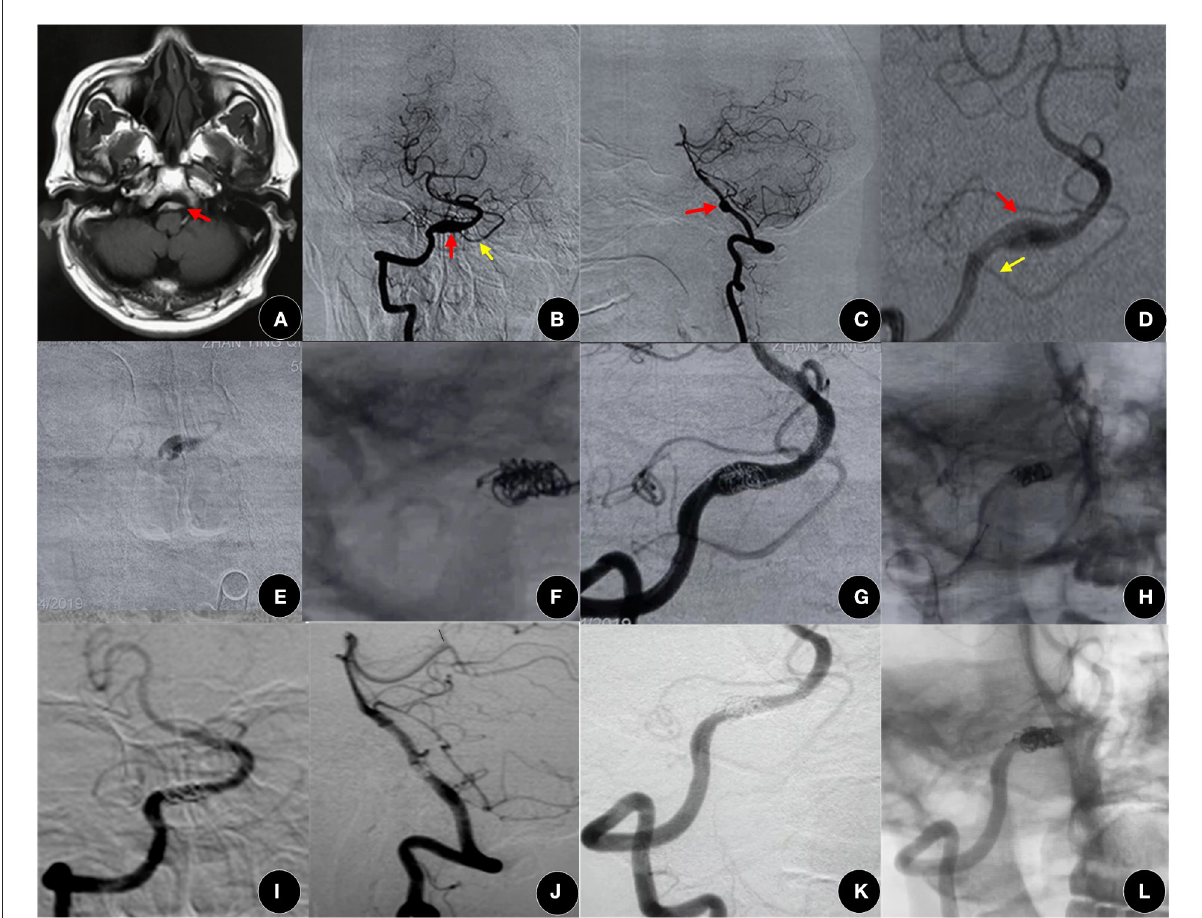
FIGURE4 A 53-year-old man presented with SAH for 2 days. (A–D) MRI images indicated an aneurysm in the vertebrobasilar system (red arrow). (B–D) Angiographic images showed a vertebral artery dissecting aneurysm (red arrow) with a double aneurysmal cavity, located in the proximal posterior inferior cerebellar artery (yellow arrow). (E) It was confirmed that the microcatheter was in the aneurysmal cavity by the hand bolus injection contrast medium. (F) After releasing several coils, a Leo plus stent (3.5mm × 25mm) was deployed to press these coils evenly into the cavity, and then the other coils were continuously packed. (G,H) Good occlusion (OKM grade C) was achieved, and the VA and PICA were patented. (I–L) The embolism degree increased to complete occlusion (OKM grade D) and the modified Rankin scale (mRS) maintained a score of 0 at 13 months after surgery. VA, vertebral artery; PICA, posterior inferior cerebellar